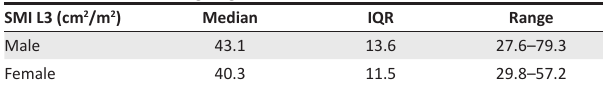
TABLE 3: SMI L3 according to